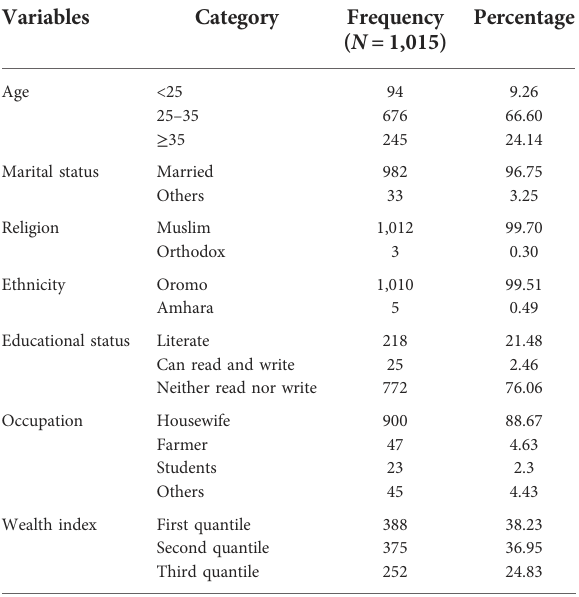
TABLE 1 Sociodemographic and economic characteristics of pregnant women at Kersa and Haramaya HDSS sites, 2021